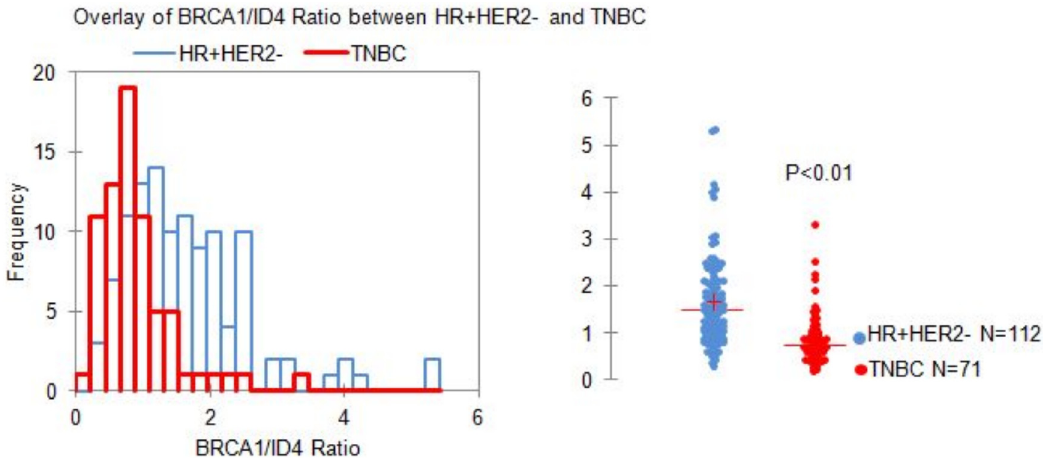
Fig 4. Distribution of BRCA1/ID4 ratio values in luminal tumors compared to TNBCs. Distribution of BRCA1/ID4 ratio values in luminal tumors compared to TNBCs. An overlay of the histograms in panel A clearly shows the marked “ Left-Skew ” of TNBCs and a relatively “ Right-shifted ” distribution of luminal (HR+) tumors. The median value is significantly different in the two classes ( * p < 0.01- Mann Whitney U test).